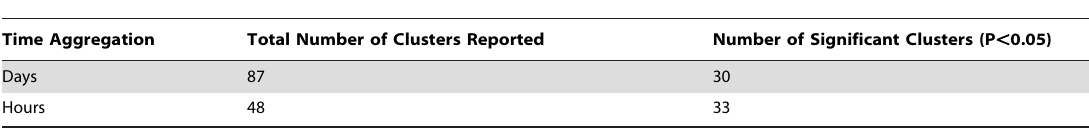
Table 2. Initial results from the space-time scan statistic model across differing temporal aggregations.